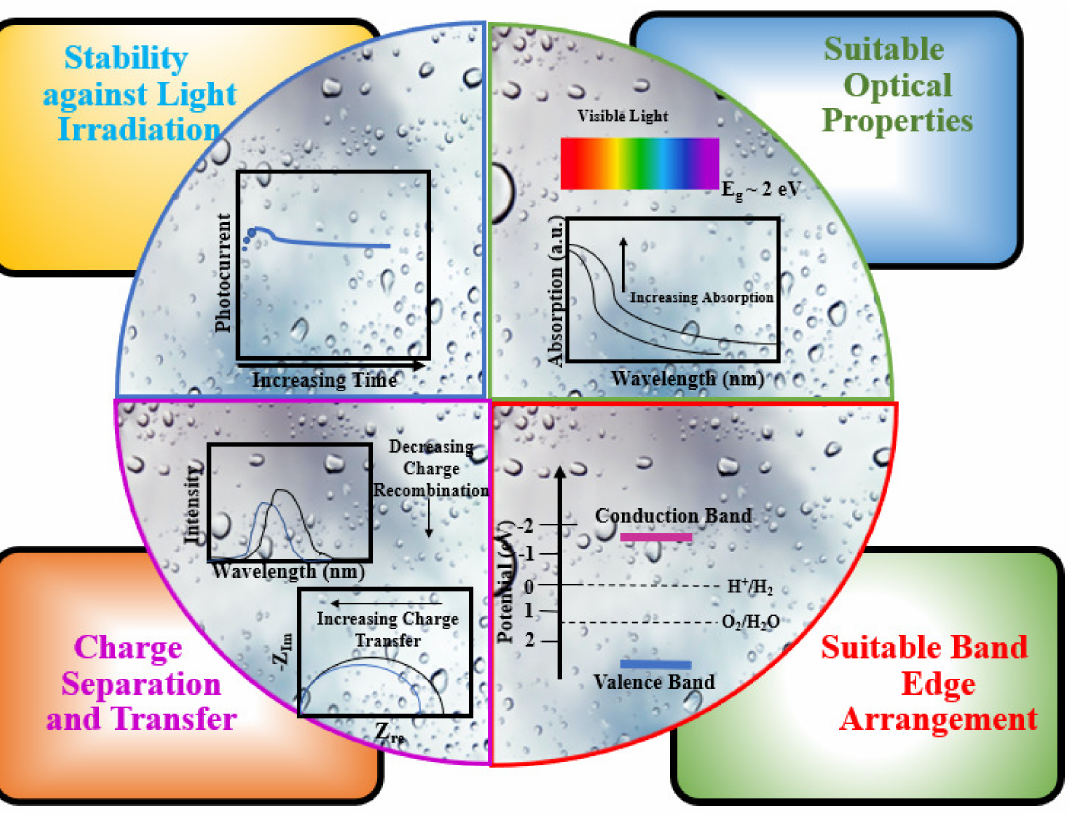
Figure 18. Important requirements for an appropriate semiconducting material as a photoelectrode for water splitting